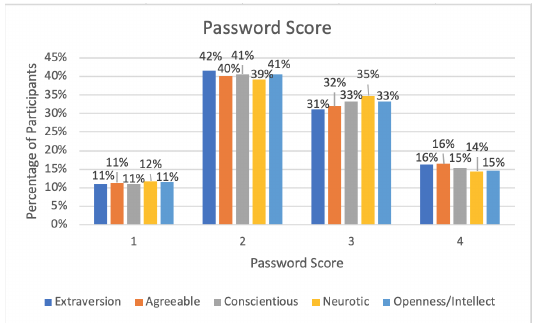
Figure 4. Big Five personality traits and password scores. This graph only includes Big Five personality trait scores above 36.